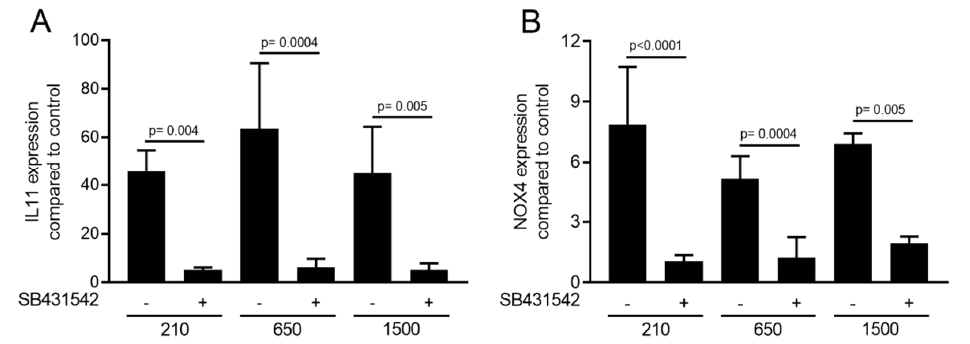
Figure 3. Expression changes were blocked in the presence of the TGF- β receptor type I kinase inhibitor. Gingival fibroblasts were exposed to 30% of PRF lysates prepared at different g -forces with and without the TGF- β receptor 1 antagonist SB431542. Expression analysis of ( A ) IL11 and ( B ) NOX4 is expressed as x-fold increases compared to the basal levels of untreated cells. Bar graphs show the means and standard deviation of three independent experiments. Statistical analysis was based on a paired t -test.